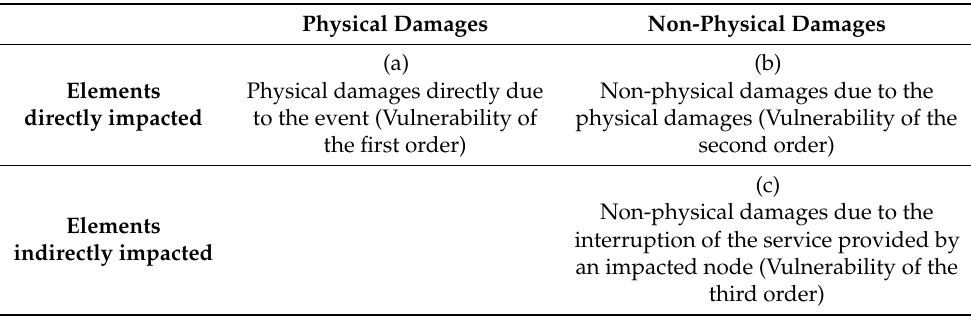
Table 1. Types of